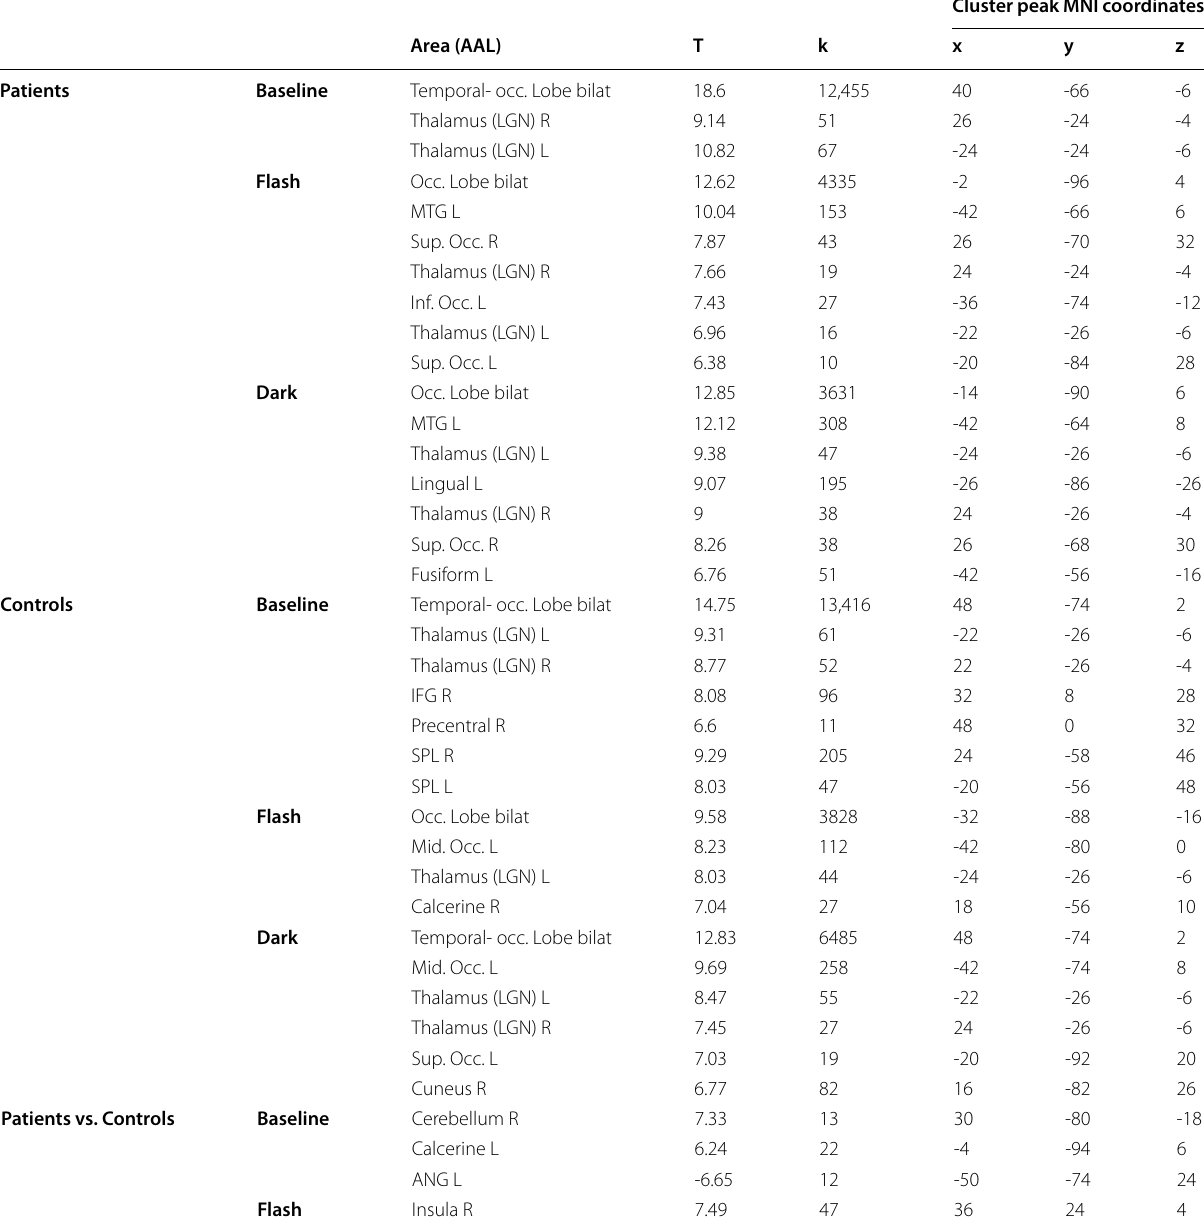
Table 2 Significant light-induced activation at baseline, after Flash and Dark (FWE 0.05, k